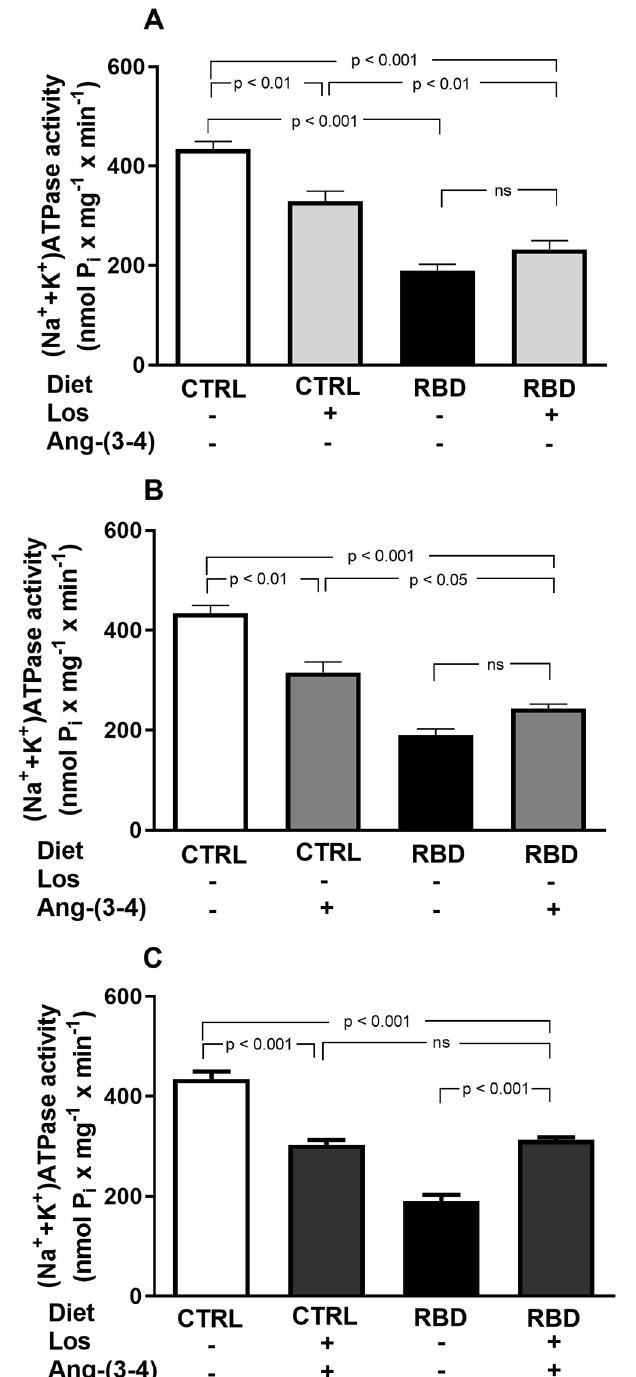
Fig 13. Downregulation of the ouabain-sensitive (Na + +K + )ATPase from renal proximal tubule cells of chronically undernourished rats. Determinations were carried out in plasma membrane-enriched preparations isolated from the outermost region of the renal cortex ( cortex corticis ) on day 92. (A) Effects of Losartan. Comparison of (Na + +K + ) ATPase activity of CTRL and RBD rats without chronic administration of Losartan, and effects of Losartan administration (30 mg/kg body mass per day, from 28 to 92 days of life) to CTRL and RBD rats, as indicated on the abscissa . (B) Responses to Ang-(3–4). Effects of oral administration of a single dose of Ang-(3–4) (80 mg/kg body mass) on (Na + +K + )ATPase activity of CTRL and RBD rats, as indicated on the abscissa . (C) Responses to Losartan +Ang-(3–4). Effects of combined administration of Losartan and Ang-(3–4) on (Na + +K + )ATPase activity of CTRL